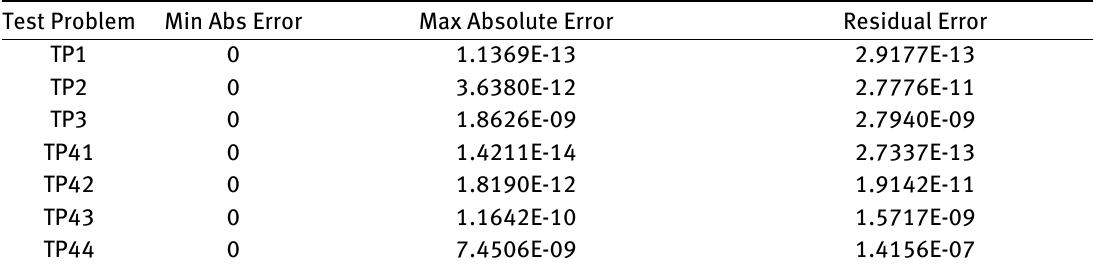
Table 1: Errors for the MFPTs (Double Precision).